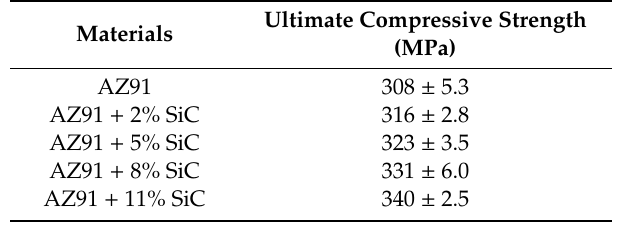
Table 5. Ultimate compressive strengths of AZ91 alloy and its composites.